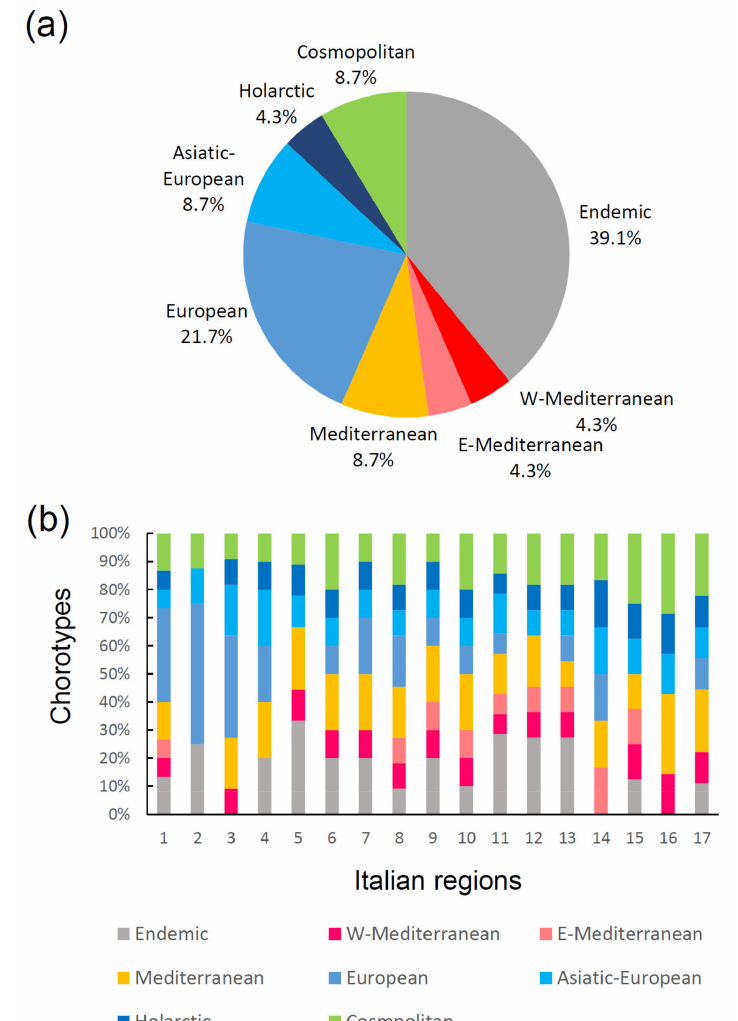
Figure 5. Chorological composition of the Italian earwig fauna: ( a ) proportion of earwig chorotypes for the whole fauna; ( b ) proportions of chorotypes in each Italian region. Regions are numbered as in Figure